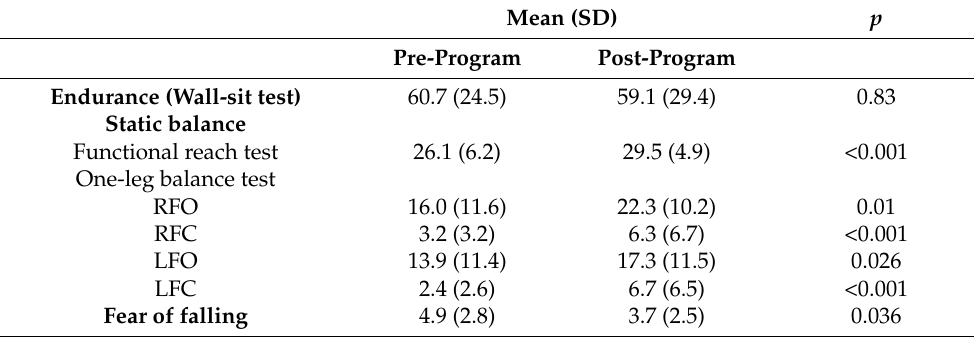
Table 2. Effects of the program on endurance, static balance and risk of